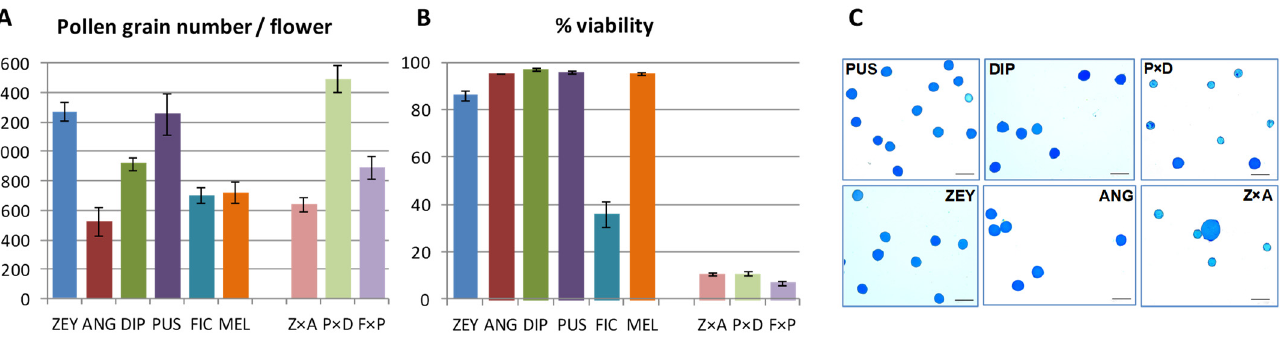
Figure 6. Pollen fertility in Cucumis spp. accessions and the interspecific hybrids producing male flowers. ( A ) Total pollen grains per flower. ( B ) Pollen viability estimated as the ratio [fertile pollen grains: total pollen grains]. Bars represent the average and standard deviation estimated from three male flowers for each accession. ( C ) Lactophenol blue staining of fertile (dark blue) and non-fertile pollen (soft blue) grains from the interspecific hybrids P × D and Z × A and their parents. Scale bars on the bottom right corner correspond to 100 µm.